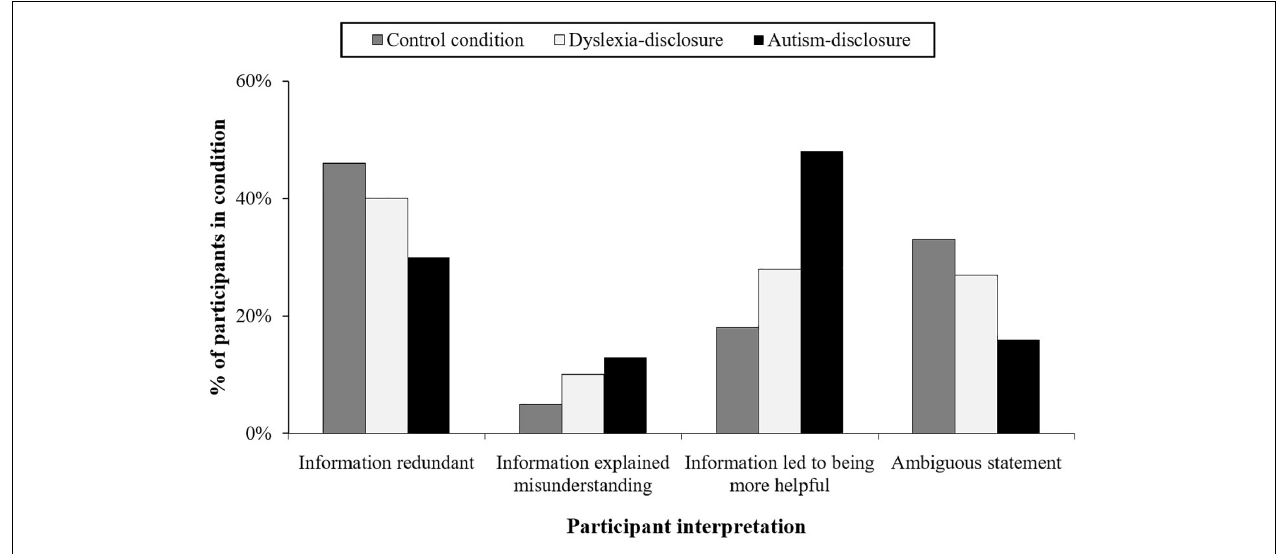
FIGURE 2 | Comparison of participants’ perceptions about the information provided by the AC.